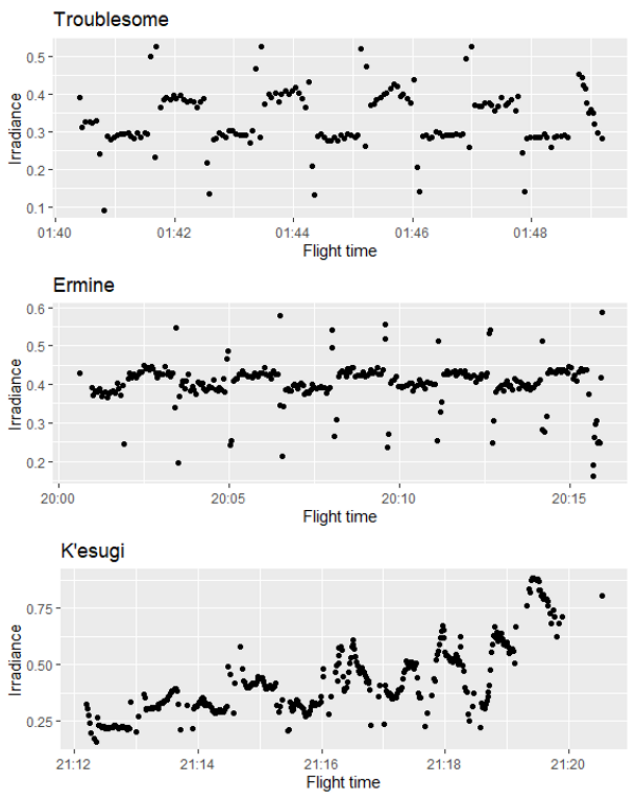
Figure 6. Relative irradiance plots at three UAV sites flown on different days. Solar zenith angles were 57.5° (Troublesome), 42.2° (Ermine), and 4.74° (K’esugi).